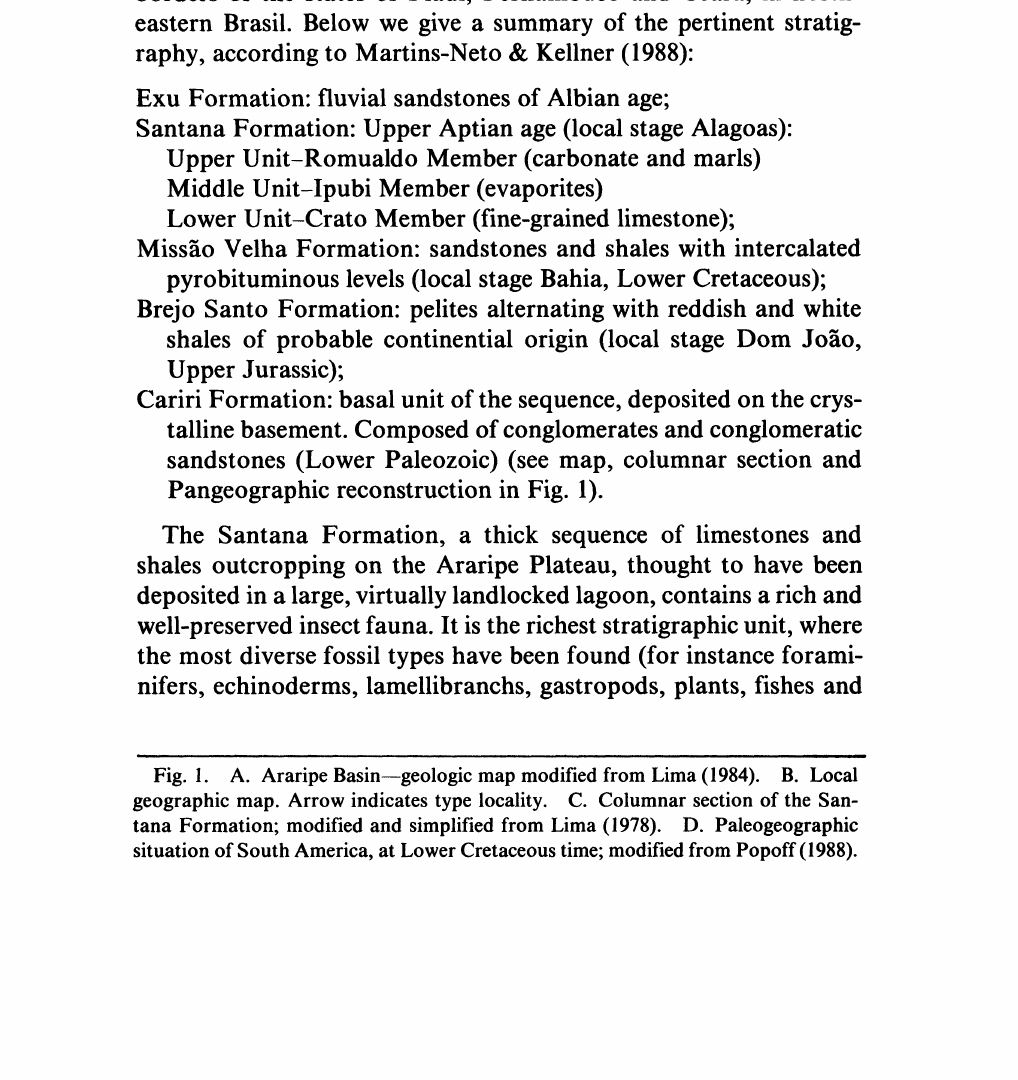
Fig. 1. A. Araripe Basin--geologic map modified from Lima (1984). B. Local geographic map. Arrow indicates type locality. C. Columnar section of the San- tana Formation; modified and simplified from Lima (1978). D. Paleogeographic situation of South America, at Lower Cretaceous time; modified from Popoff